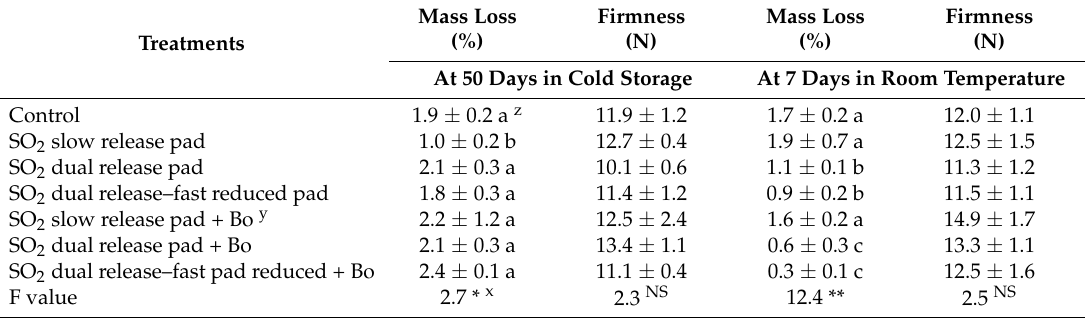
Table 3. Mass loss and firmness of ‘BRS Vitoria’ seedless table grapes at 50 days of cold storage